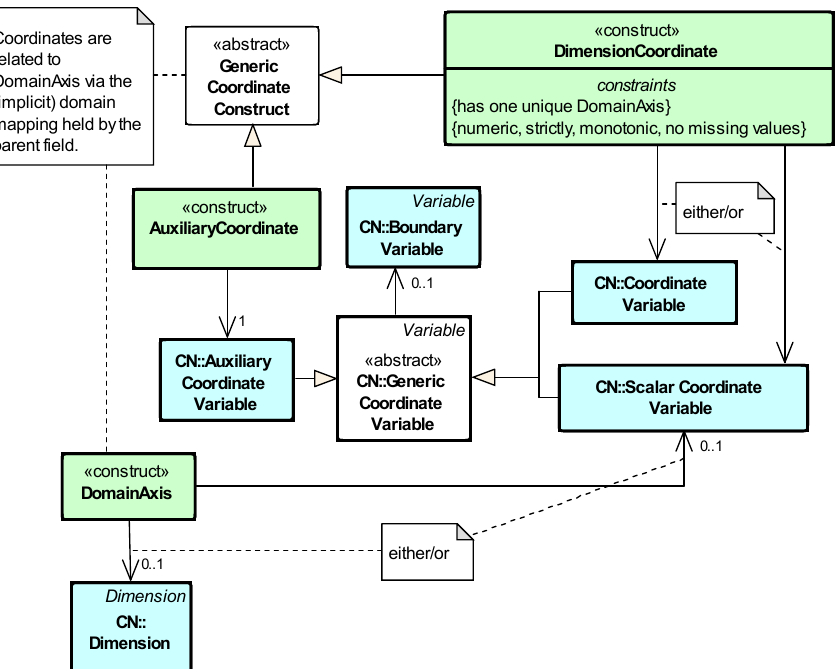
Figure 10. The relationship between domain axis, dimension coordinate, and auxiliary coordinate constructs (Sect. 4.2 and 4.3) and CF- netCDF described using UML (Appendix A). A dimension or auxiliary coordinate construct is defined by a CF-netCDF coordinate, scalar coordinate, or auxiliary coordinate variable, and the associated CF-netCDF boundary variable if it exists. A generic coordinate construct spans one or more domain axis constructs, but the mapping of which ones is only held by the parent field